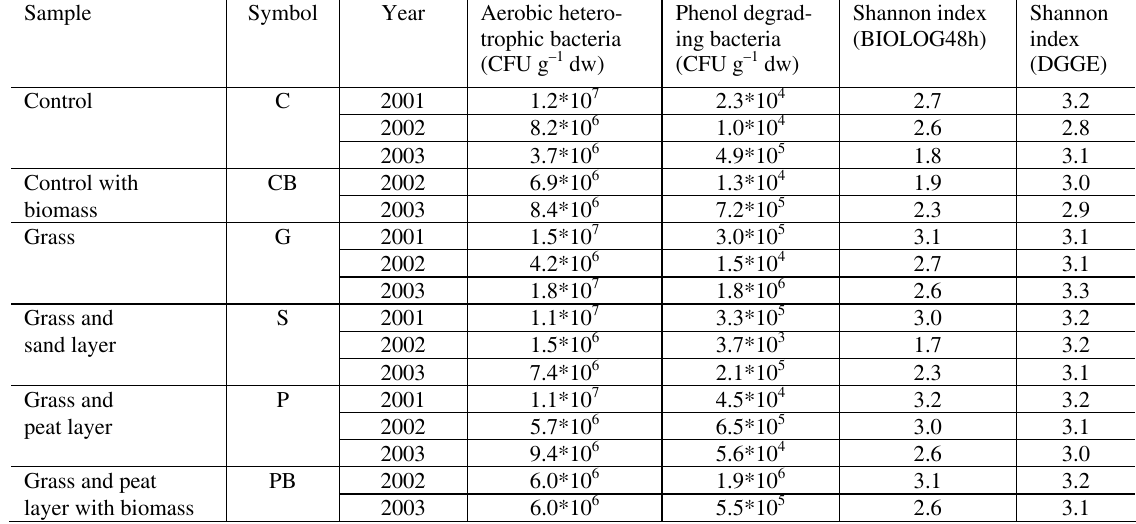
Table 2. Microbiological properties of semi-coke in different treatment plots